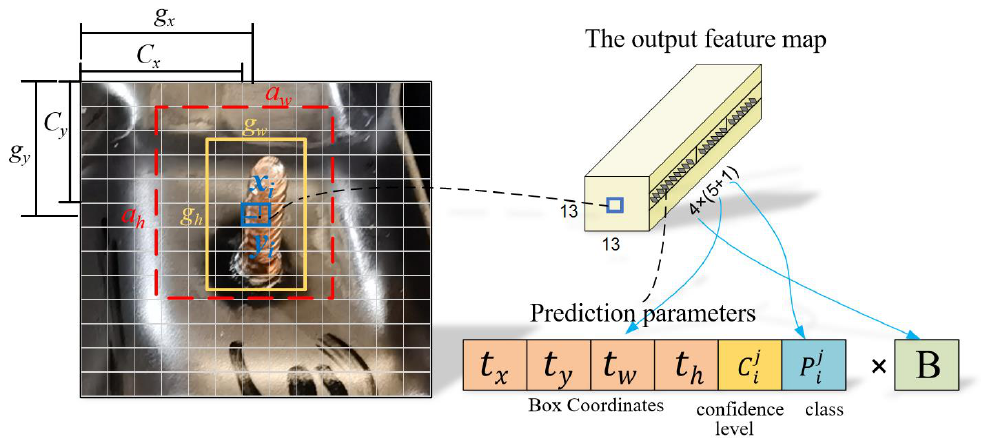
Figure 3. Predicted feature map for a 13 × 13 grid (The red dashed rectangular box is the anchoring box. The yellow rectangular box is ground truth box. The blue box represents the grid in row i and column j. ).